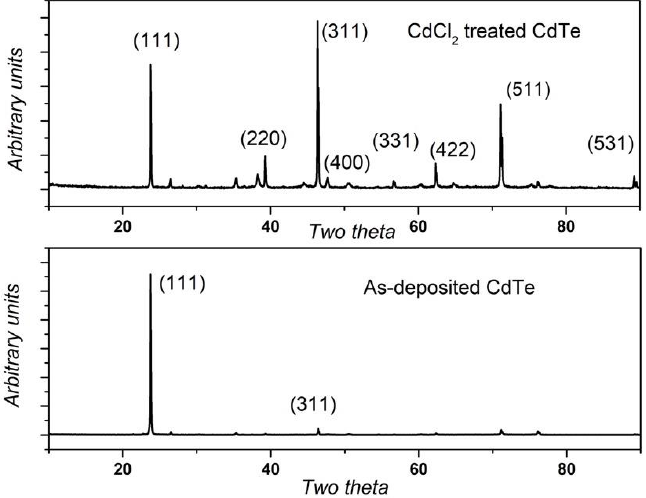
Figure 10. XRD patterns of CdCl 2 treated ( top ) and as deposited ( bottom ) CdTe layers.